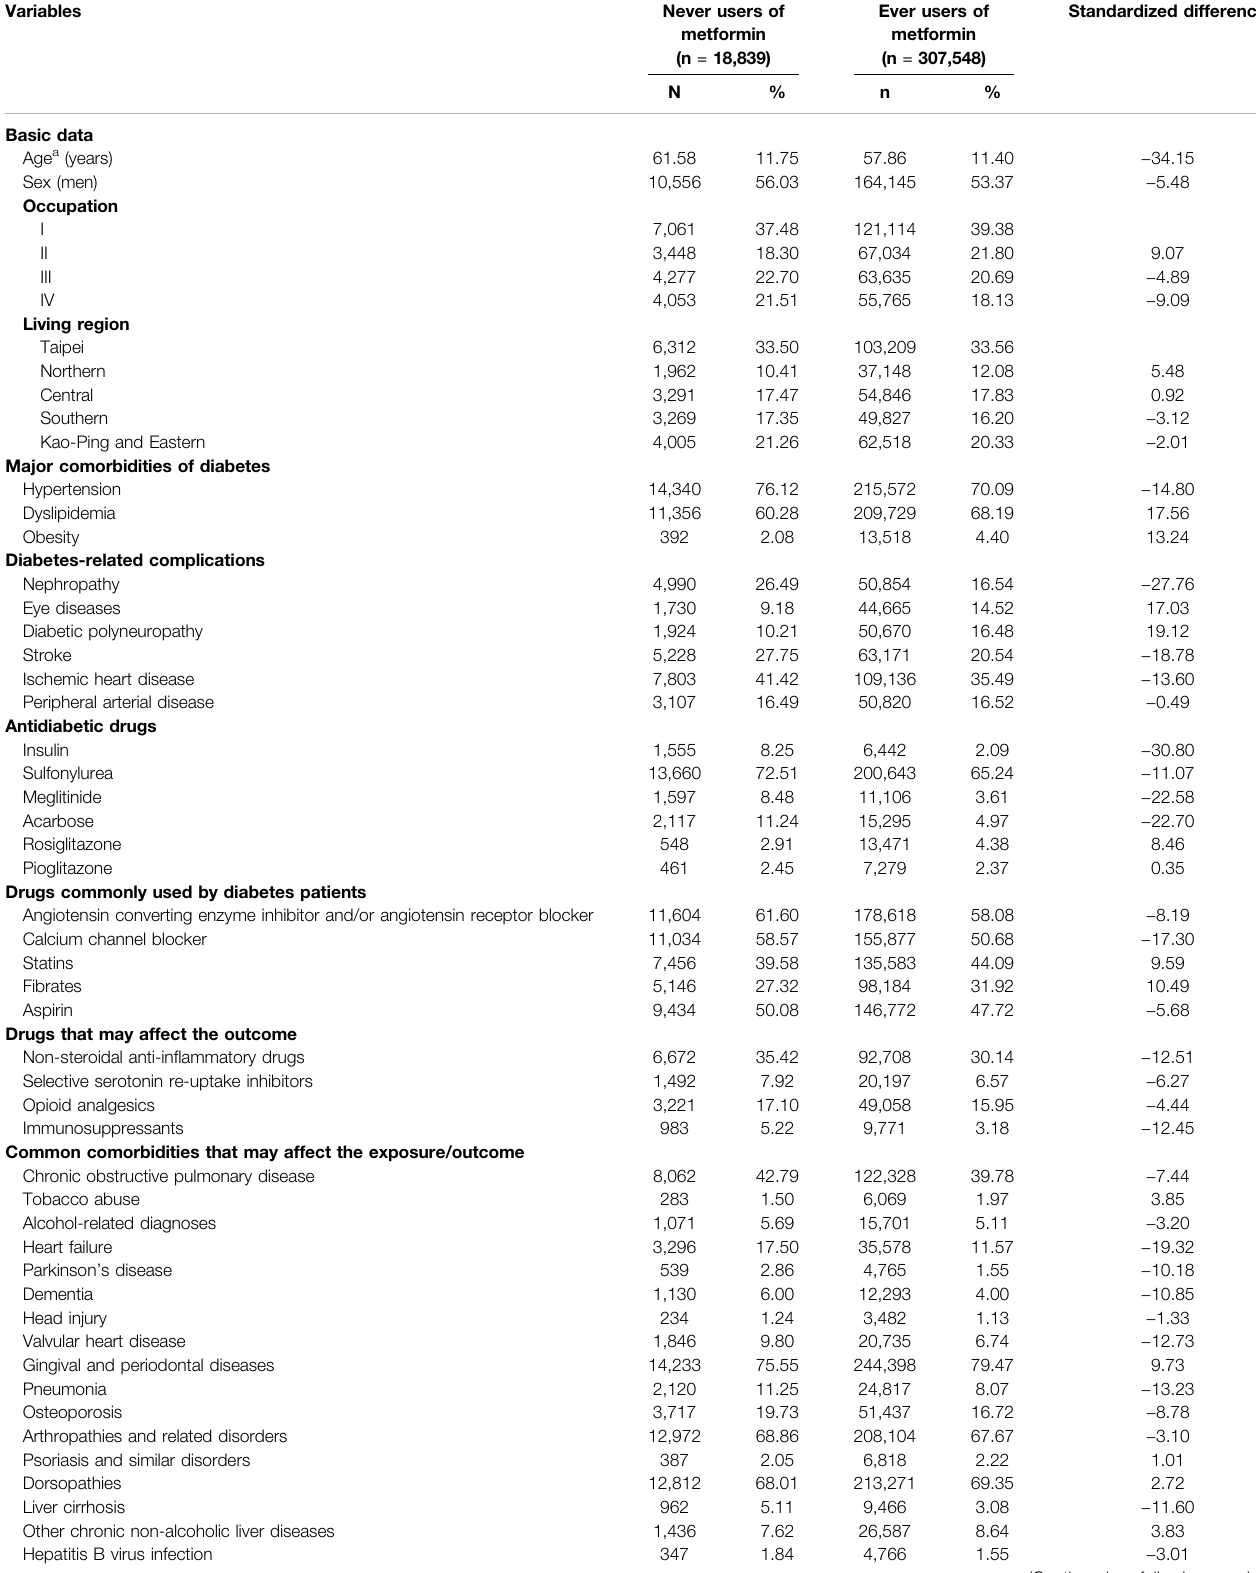
TABLE 1 | Comparison of characteristics in study subjects by metformin